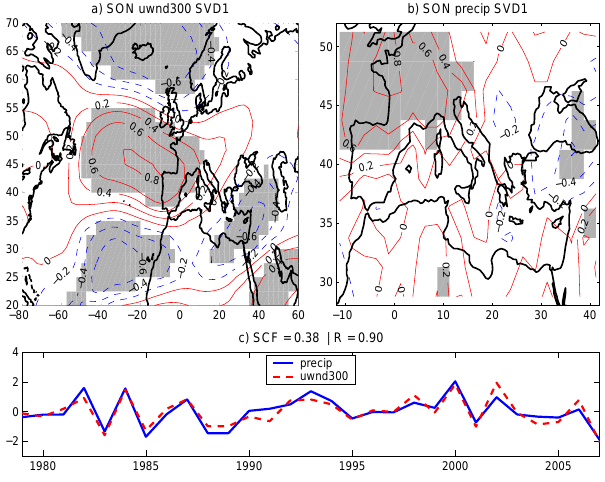
Fig. 6. Heterogeneous correlation maps of the 1st SVD mode (SVD1) between 300hPa zonal wind (a) and precipitation (b) and related expansion coefficients (c) , in fall. Positive values in red, negative values dashed in blue, 95% significance shaded in